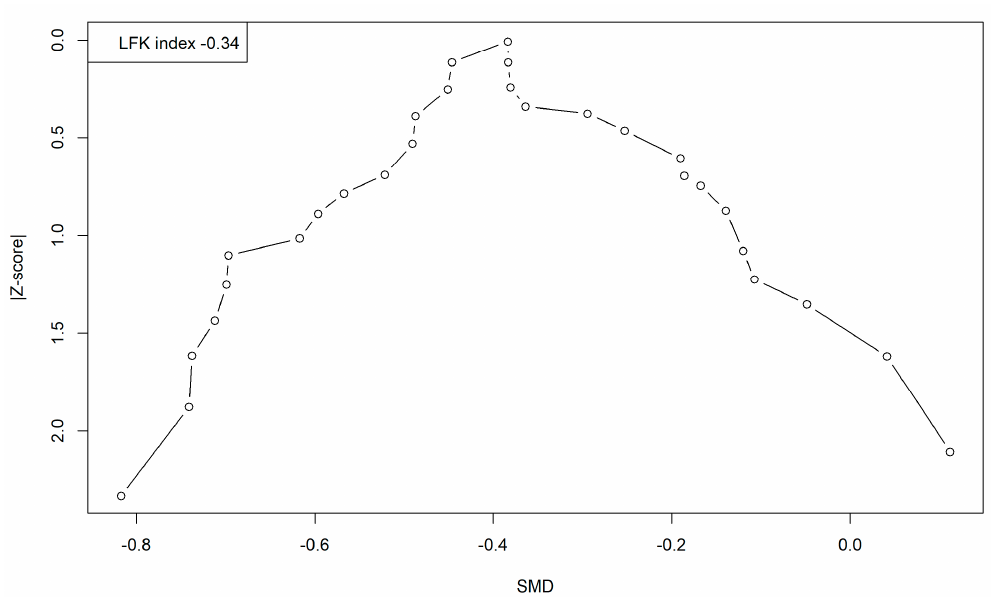
Drapery plot of the studies included in the sensitivity